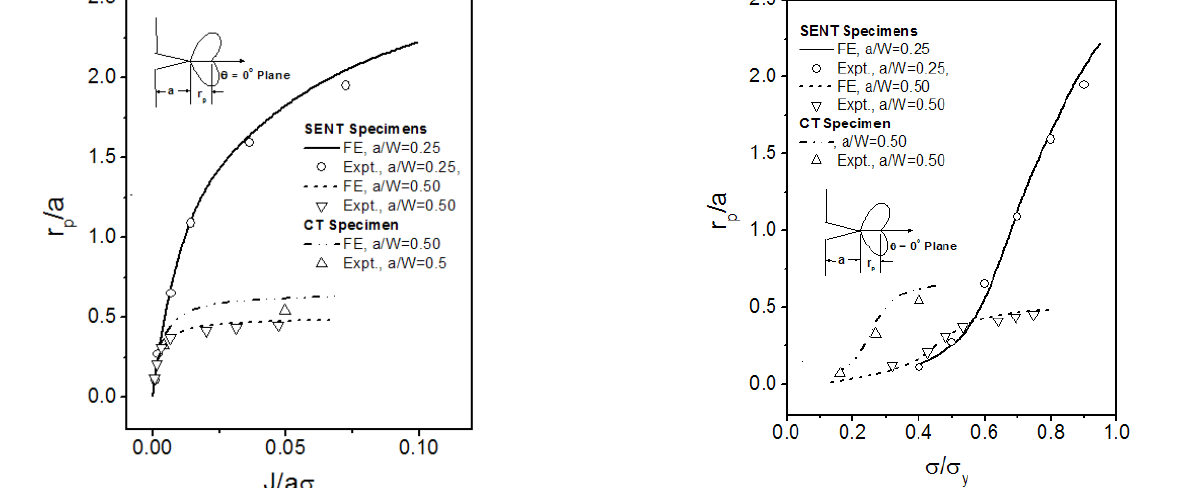
Figure 6: Variation normalized plastic zone size (r p /a) estimated by microhardness technique and FEA vs. normalized J-integral (J/a σ y ) in SENT and CT specimens